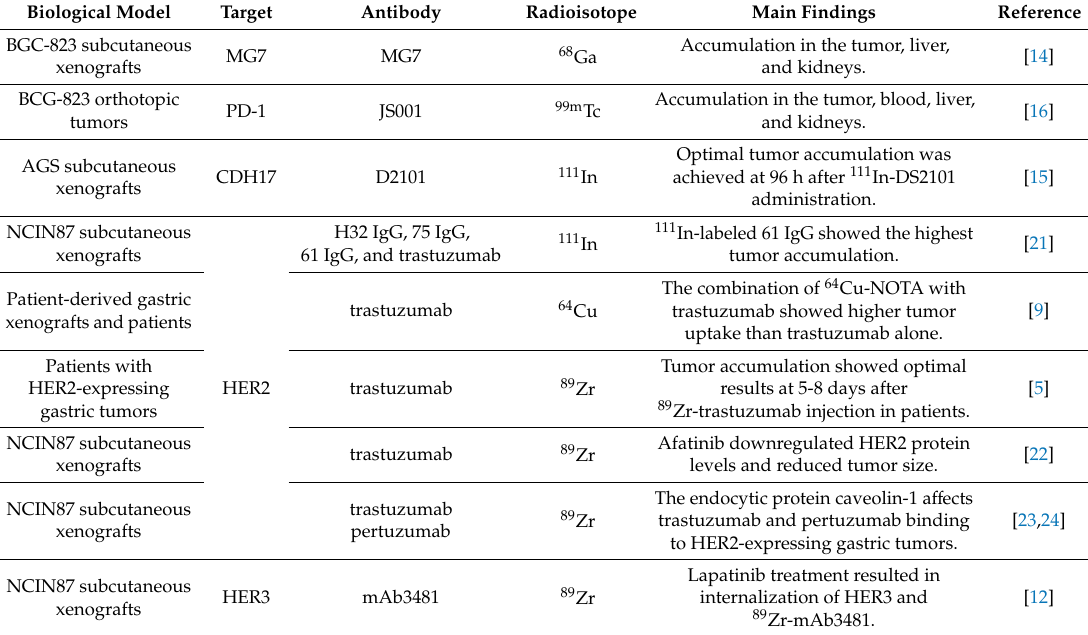
Table 1. Radiolabeled antibodies used in molecular imaging of gastric